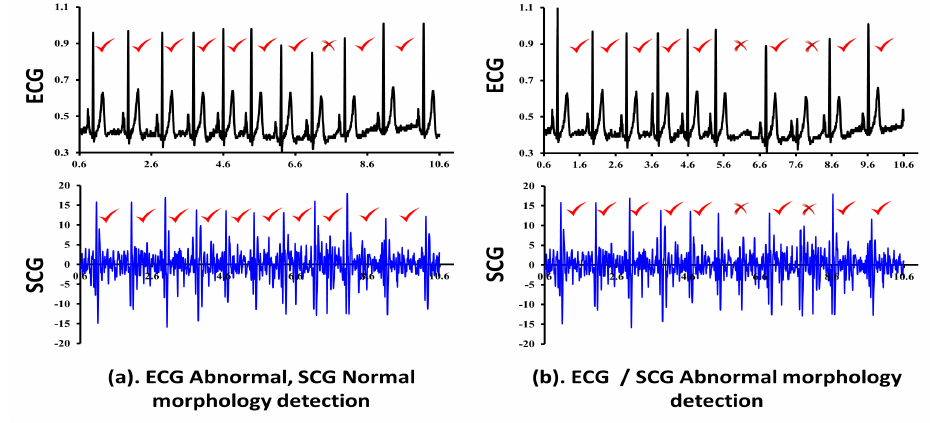
Figure 10. Combined evaluation of ECG and SCG signals using a set of 10 cardiac cycles.